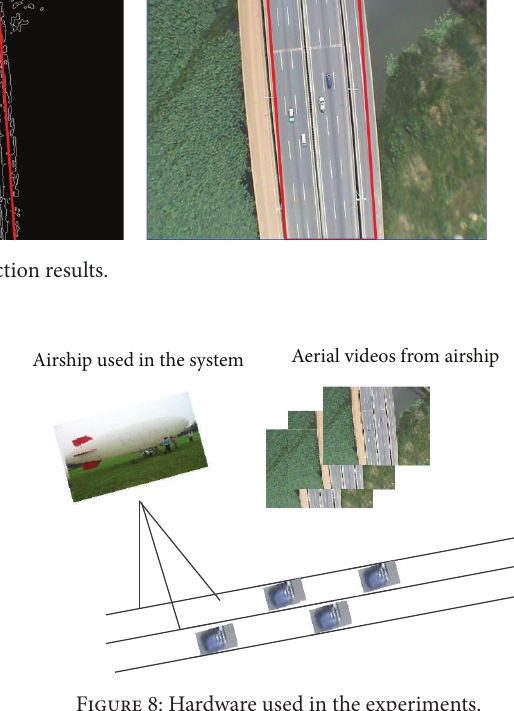
Figure 7: Initial vehicle detection results.